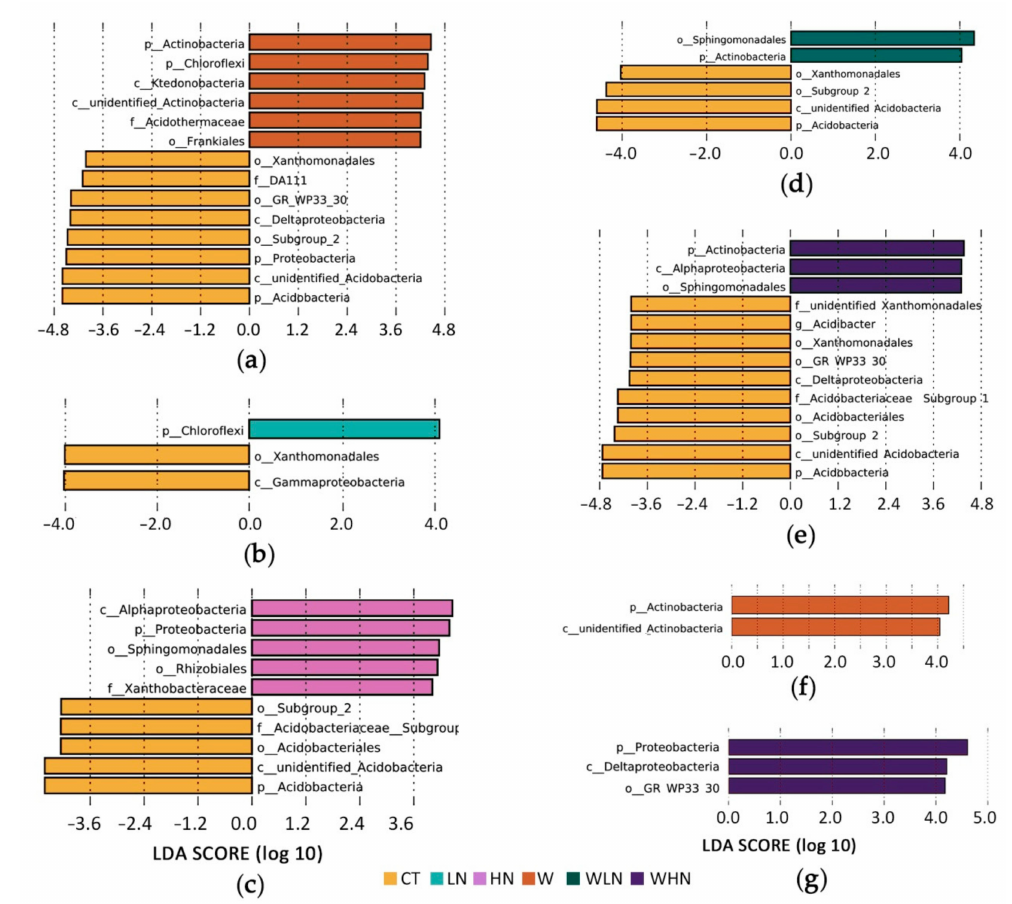
Figure 2. The linear discriminant analysis e ff ect size (LEfSe) bar graphs indicate significant di ff erences under warming and N addition. ( a ) CT–W, ( b ) CT–LN, ( c ) CT–HN, ( d ) CT–WLN, ( e ) CT–WHN, ( f ) W–WLN, and ( g )